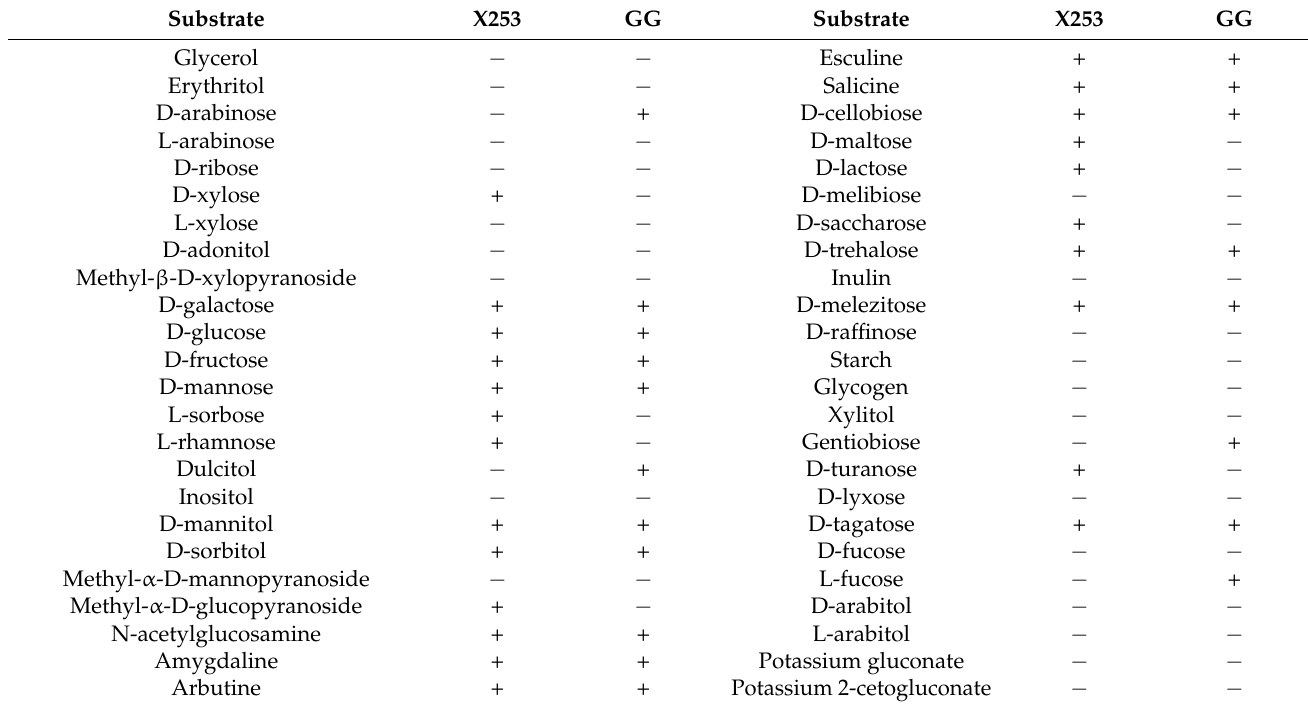
Table 5. Carbohydrate fermentation profile assessed by API 50 CHL test